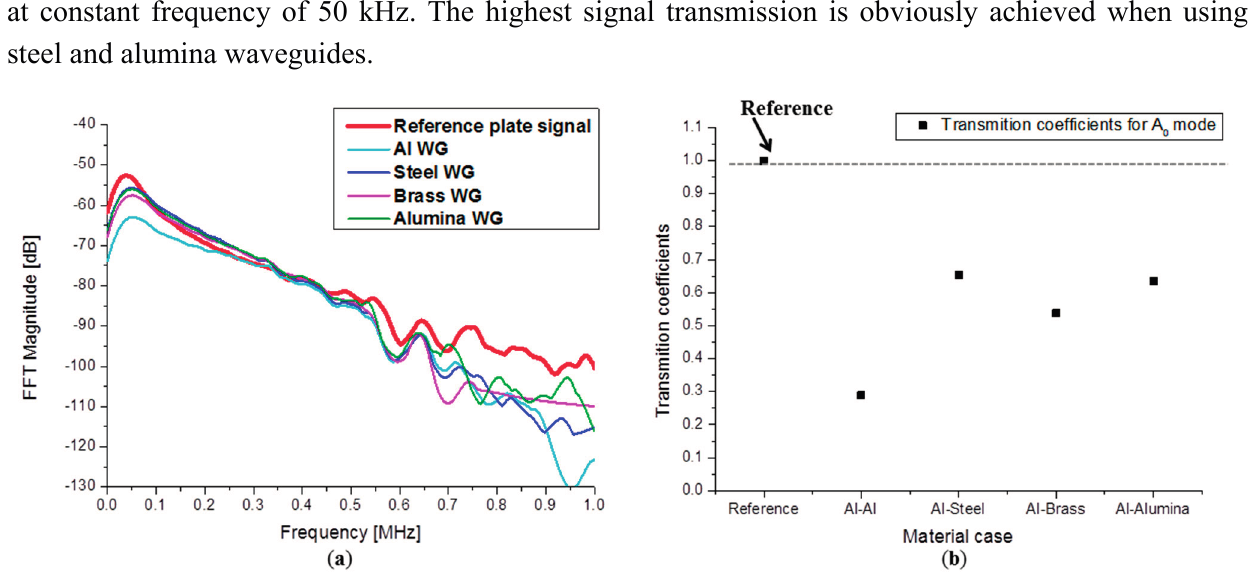
Figure 15. ( a ) Calculated FFT spectra and ( b ) A 0 transmission